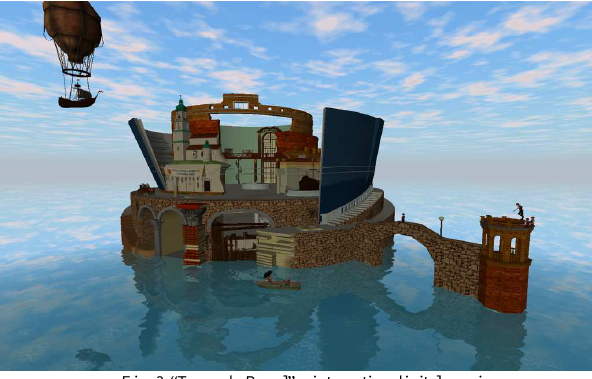
Fig. 3 “Torre de Papel” - interactive digital version.